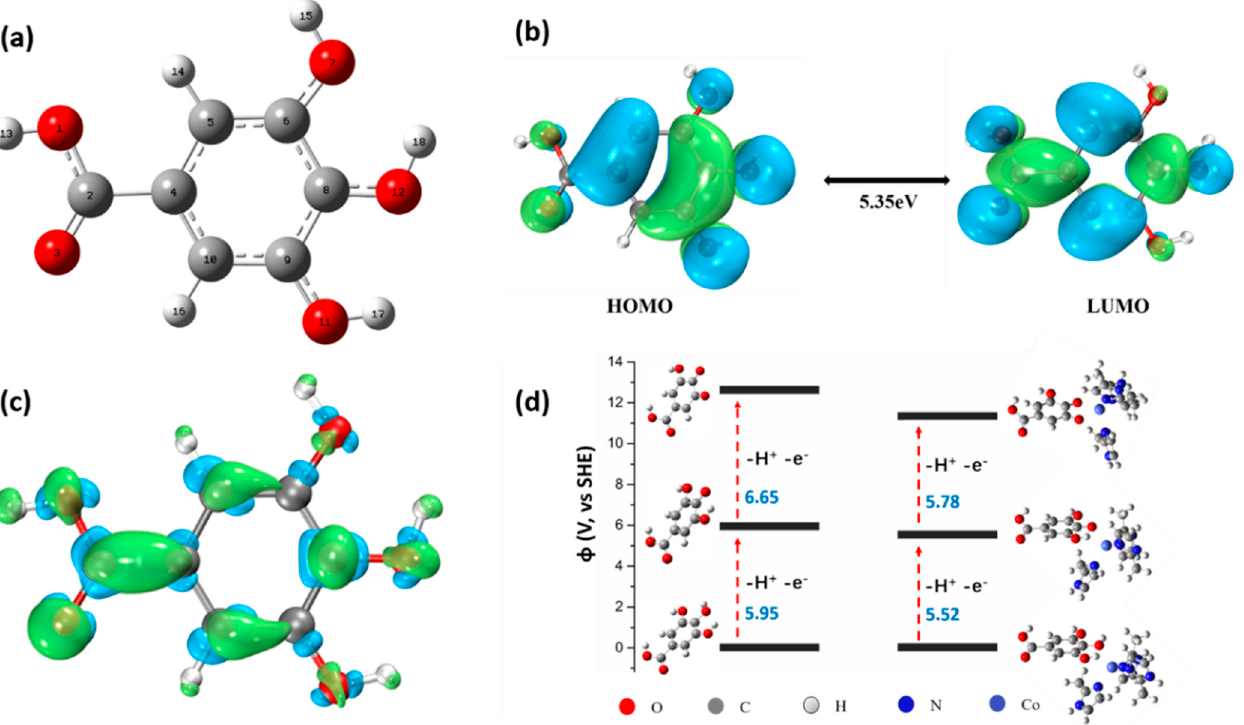
Figure 6. Optimized structure of GA and atomic label ( a ); HOMO and LUMO of GA ( b ); f (+) of N − 1 ( c ); the oxidation potential of each step with or without Co-MOF ( d ).